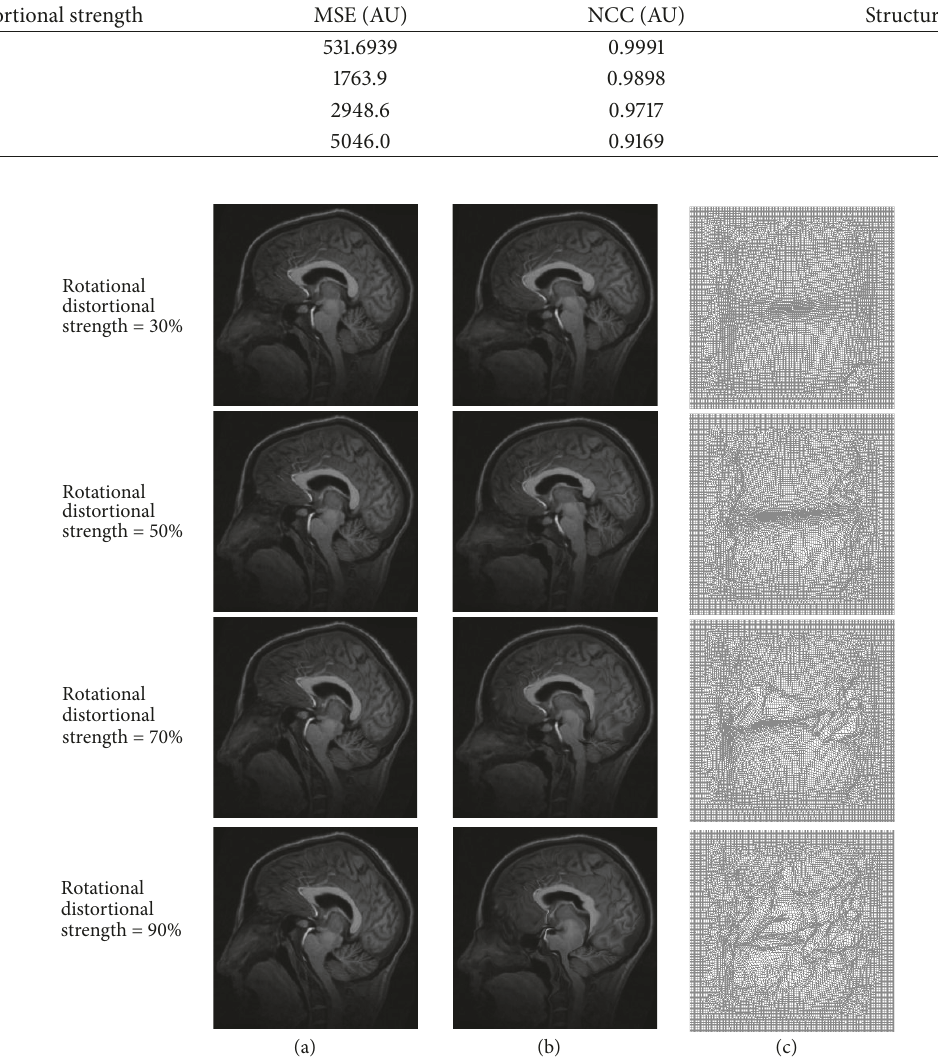
Figure 8: Medical image registration with large deformation produced by rotational distortion. (a) Moving images produced for rotational distortional strengths of 30%–90%, (b) corresponding registration results, and (c) corresponding final deformation fields.